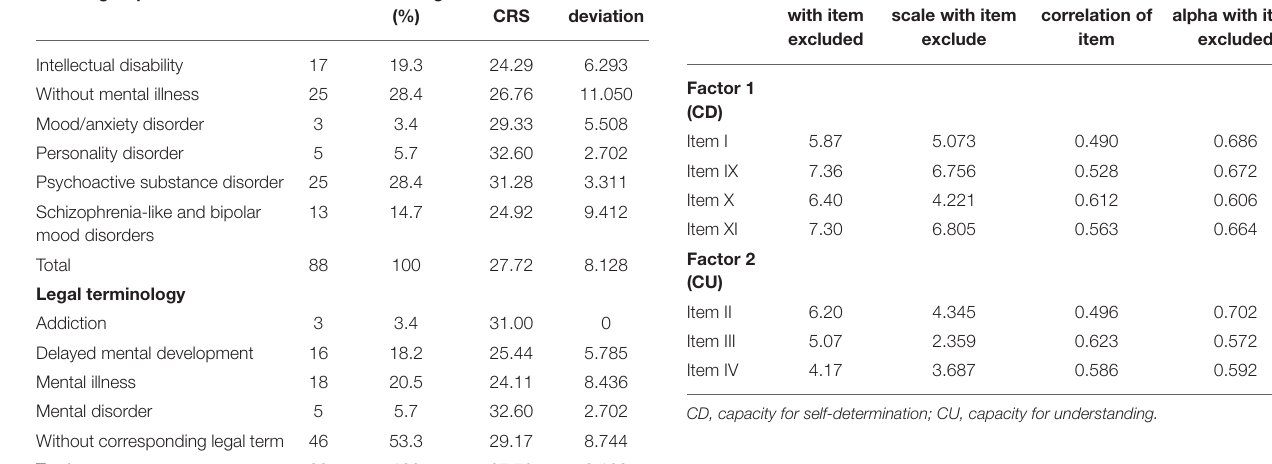
TABLE 3 | Cronbach’s alpha values with the exclusion of items (Factor 1 and Factor 2 data without subdivisions). Total corrected Variance of Mean scale correlation of scale with item with item deviation exclude excluded